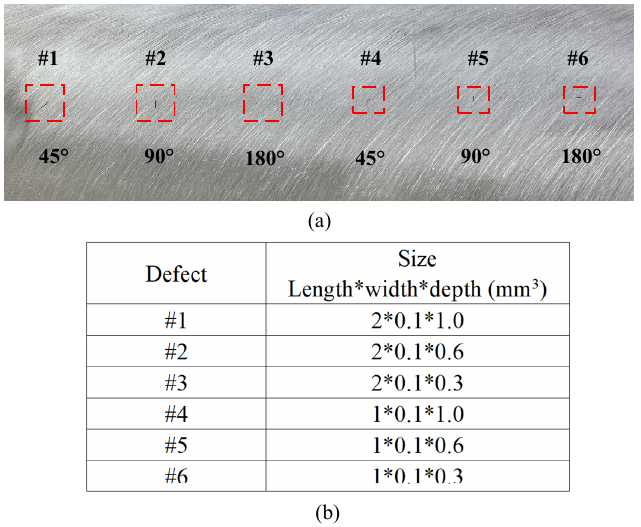
Figure 7. ( a ) Top view of the stainless sample with machined defects, ( b ) dimensions of the defects. Raw Images